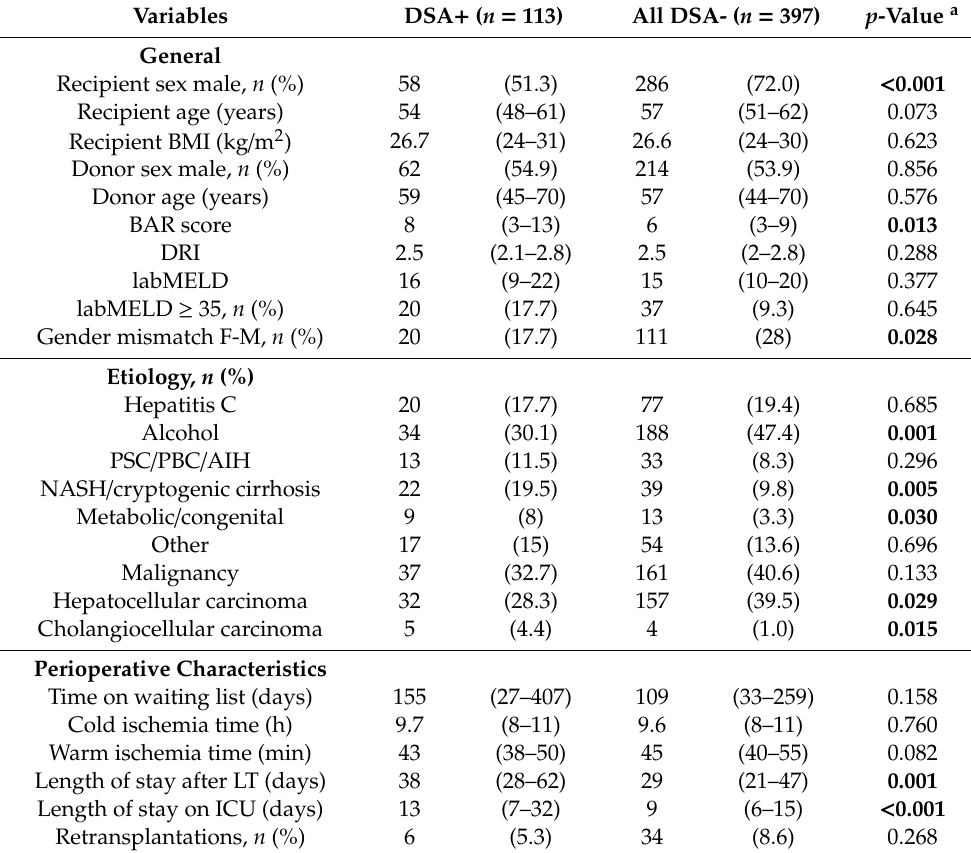
Table 1. Epidemiological, clinical, and operative data of patients who underwent LT from deceased donors between 1 January 2008, and 31 December 2015, sorted by DSA-positive versus all DSA-negative recipients